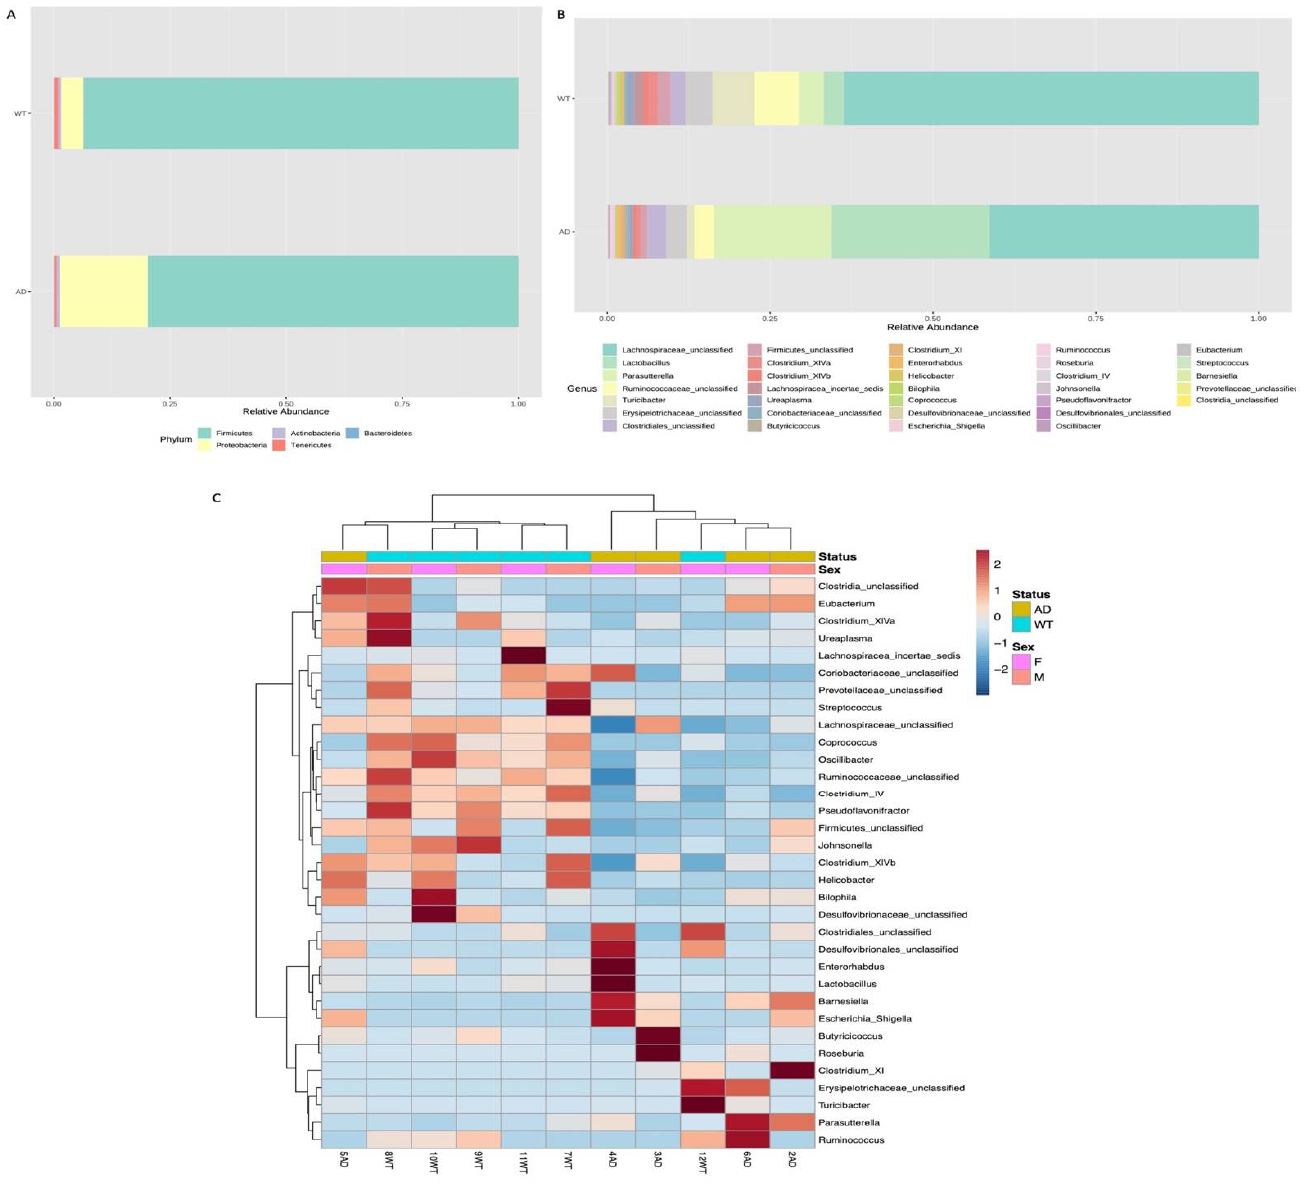
Figure 2. Bacterial composition of AD and WT mice gut microbiome. Taxonomic assignment is shown at phylum ( A ) and genus ( B ) level. For each of these taxonomic levels, the barplots show the relative abundance (%) of each identified taxon/group. A different bacterial composition is highlighted both at phylum and at genus level. A heatmap of variance was obtained by grouping the reads based on the assigned taxa: a good cluster was obtained at genus level showing a clear separation between AD and WT mice ( C ).